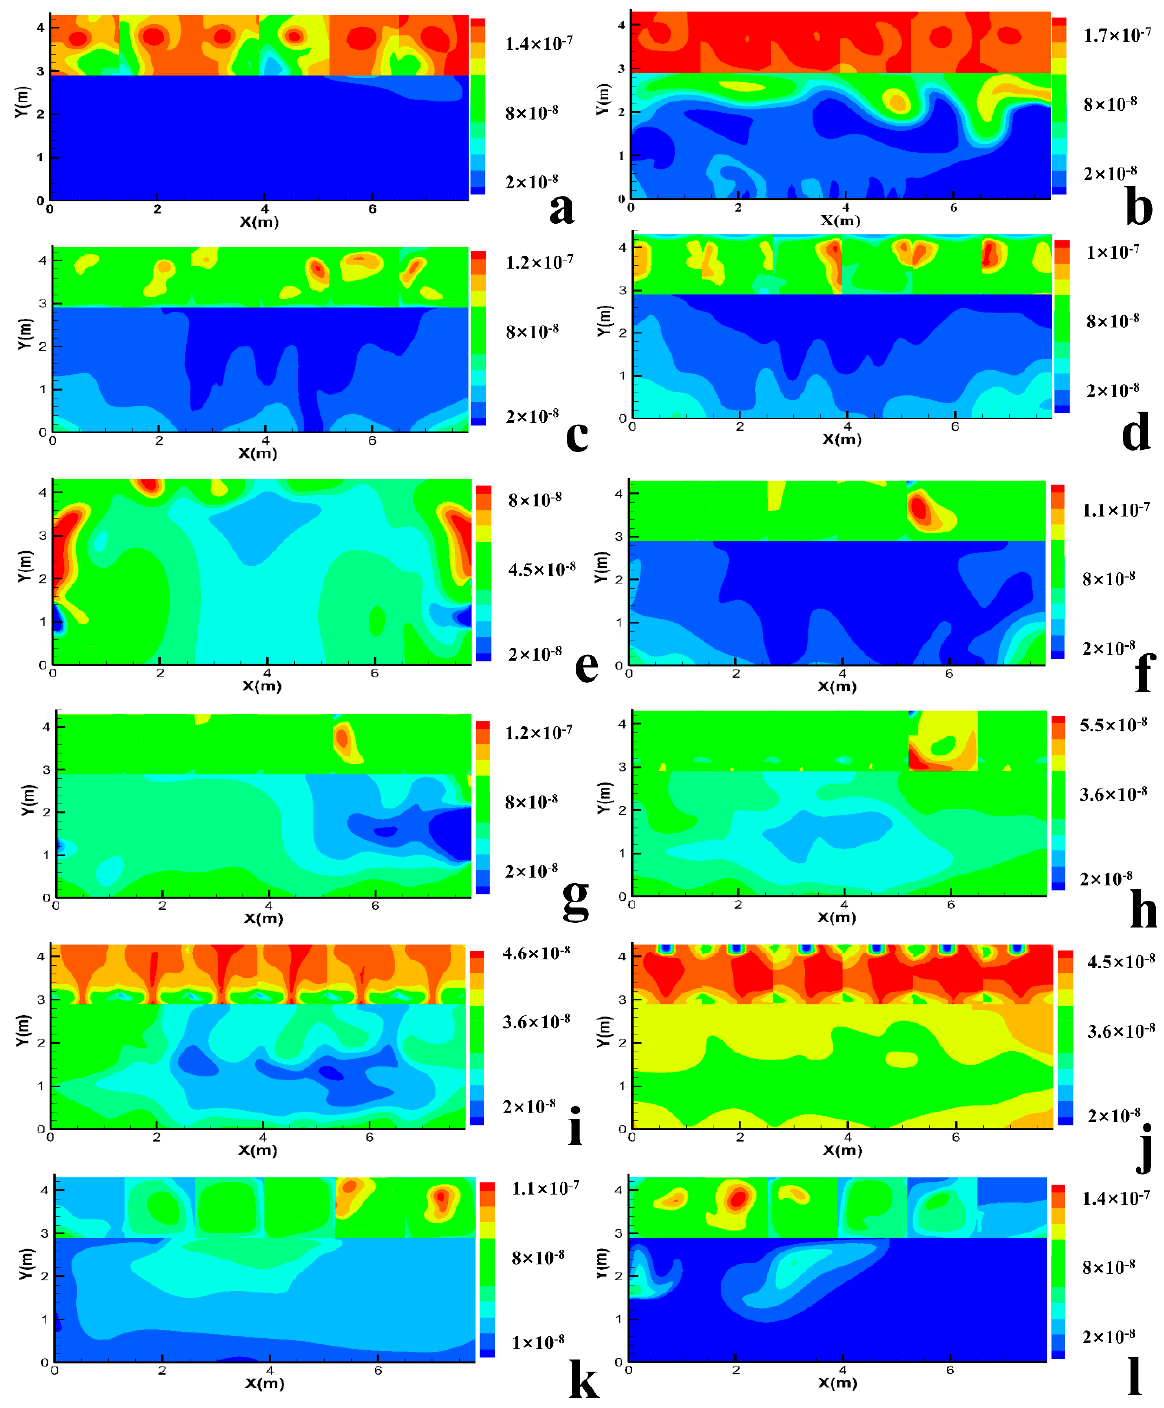
Figure 8. Hydrogen sulfide concentration distribution for different cases (Z = 1.5 m, ACH = 5): ( a – l ) MV-1– IJV-7.